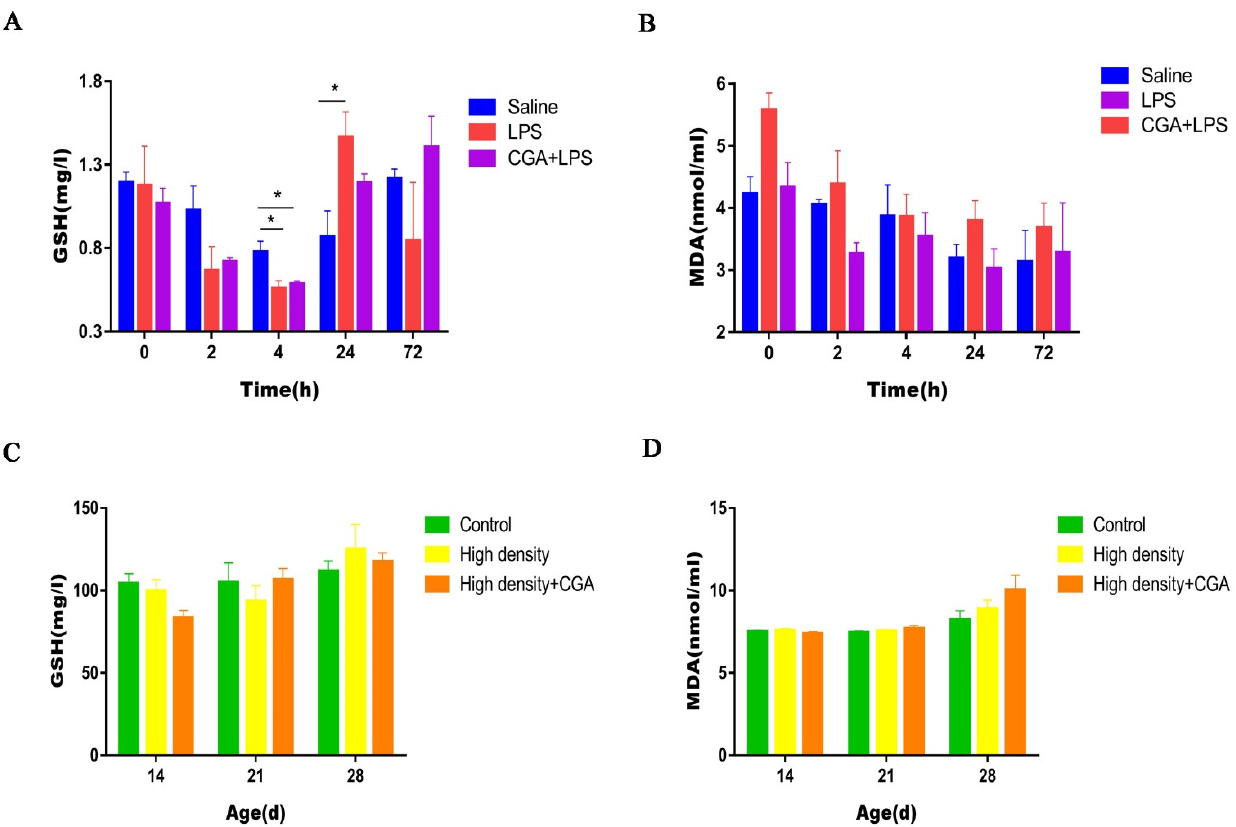
Figure 3. Effects of chlorogenic acid on serum glutathione and malondialdehyde levels of broilers challenged with immune stress and high density stress. ( A ) GSH levels of broilers challenged with immune stress. ( B ) MDA levels of broilers challenged with immune stress. ( C ) GSH levels of broilers challenged with high density stress. ( D ) MDA levels of broilers challenged with high density stress. GSH = glutathione, MDA = malondialdehyde, * means significant difference between groups.